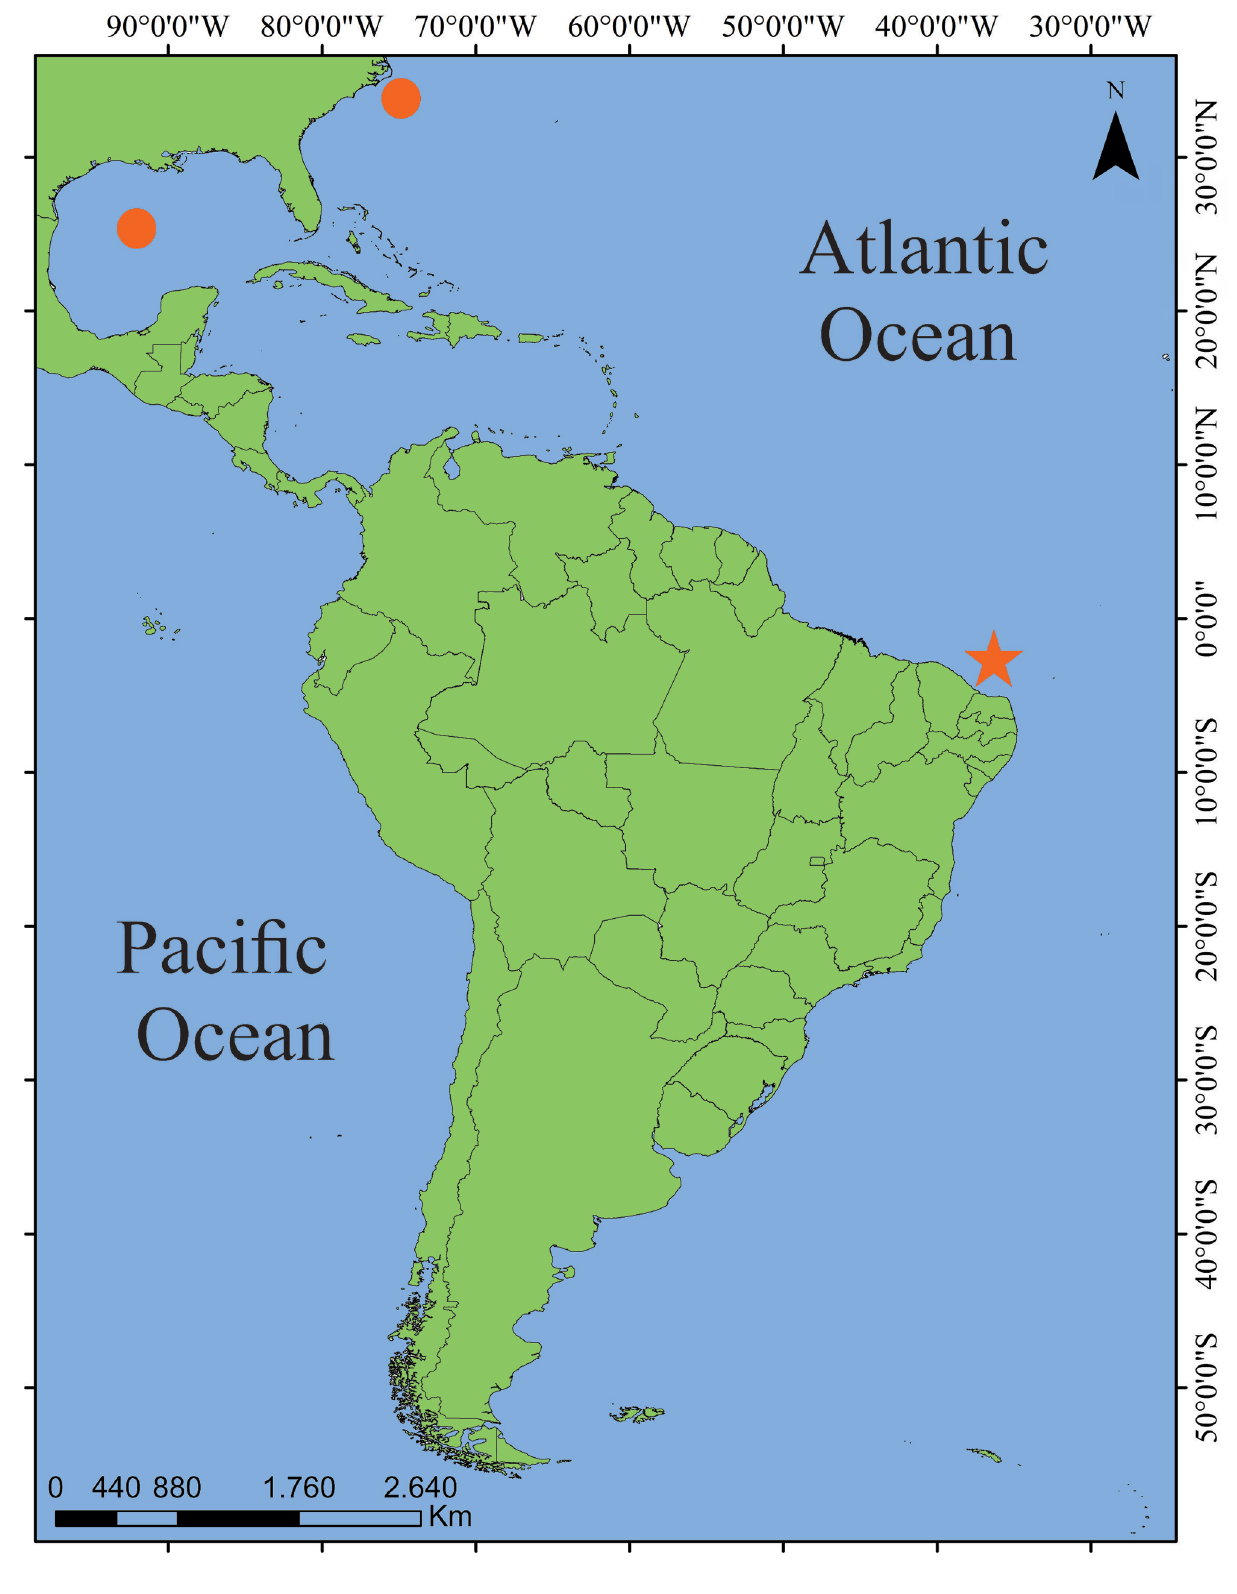
Figure 4. Geographic distribution of Anuropodione carolinensis Markham, 1974 in the Western Atlantic. Orange circles = previous records; orange star = new